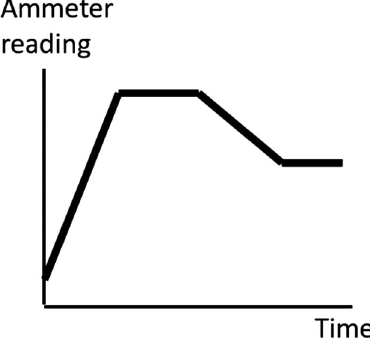
FIG. 7. Ammeter reading for coil connected to power supply in